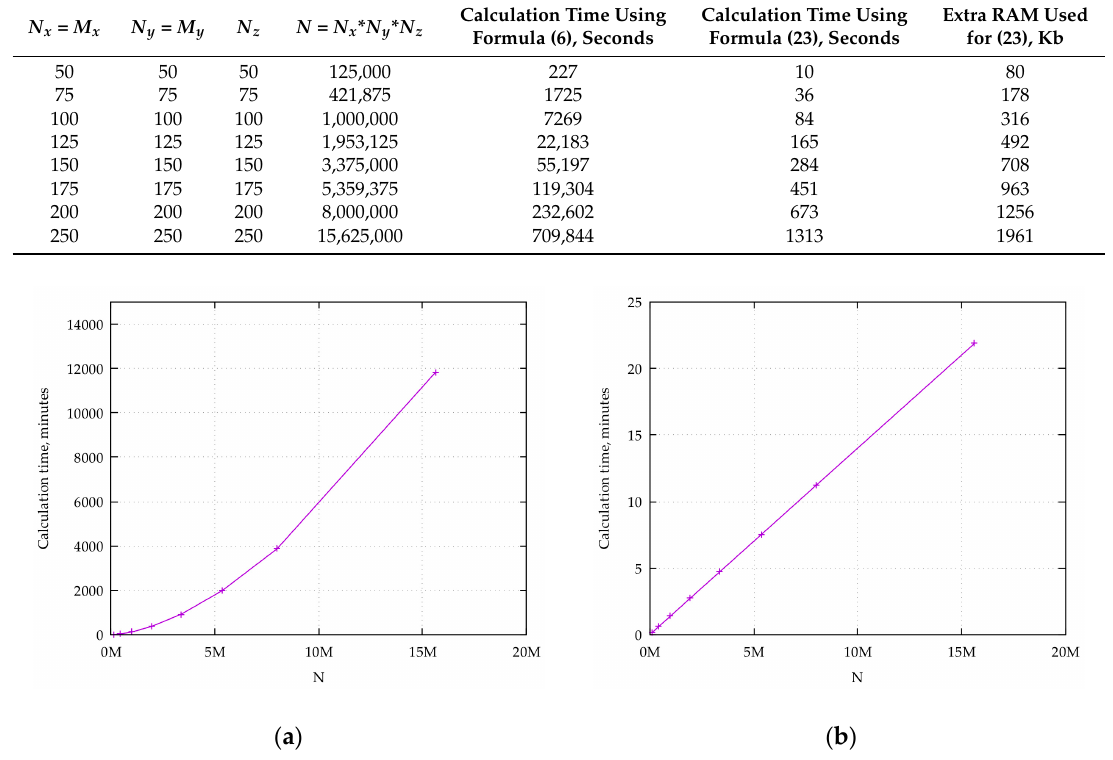
Table 1. Dependence between the calculation time and partitioning parameters.